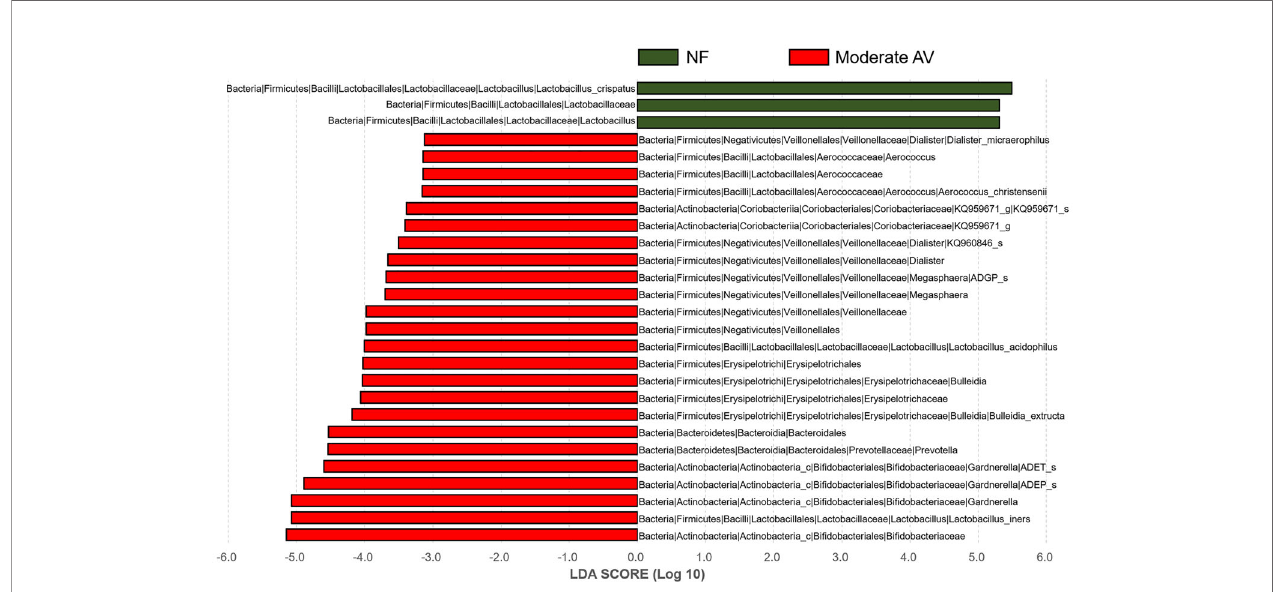
FIGURE 4 | Differential abundance of the bacterial taxa between normal fl ora and moderate aerobic vaginitis groups. Linear discriminant analysis (LAD) effect size (LEfSe) analysis of the microbial pro fi les showed signi fi cant differences in the abundance of bacterial taxa between normal fl ora (NF) and moderate aerobic vaginitis (AV) based on their AV scores. NF and moderate AV are indicated by green- and red-colored bars, respectively. The minimum LDA score was set at